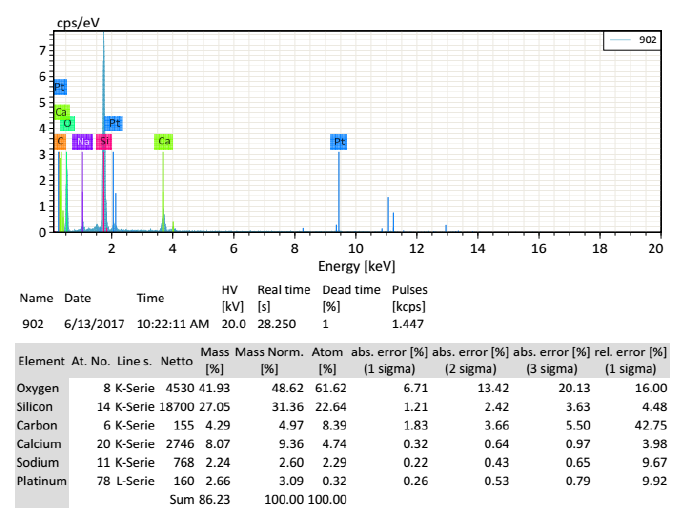
Figure 4. Energy spectrum of solid wall of hollow glass microsphere (HGM).